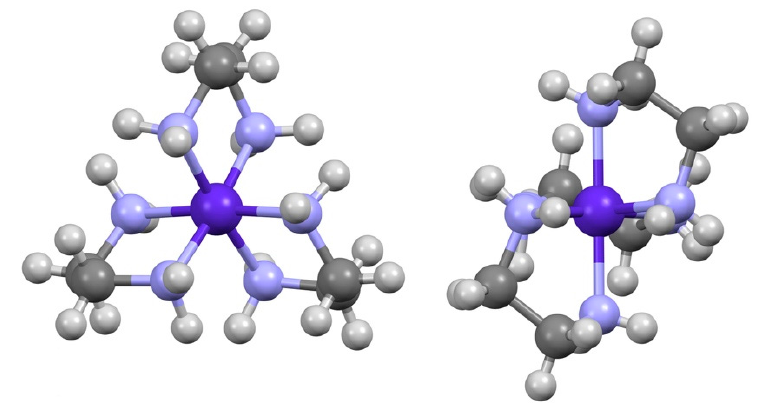
Figure 1. View down the molecular C 3 - and C 2 -axes of ∆ ( λ , λ , λ )-[Co(en) 3 ] 3+ showing the different helicities, P and M respectively, established by the arrangement of the chelating ligands. In ∆ ( λ , λ , λ )- [Co(sep)] 3+ , the molecular C 3 -axis is capped.